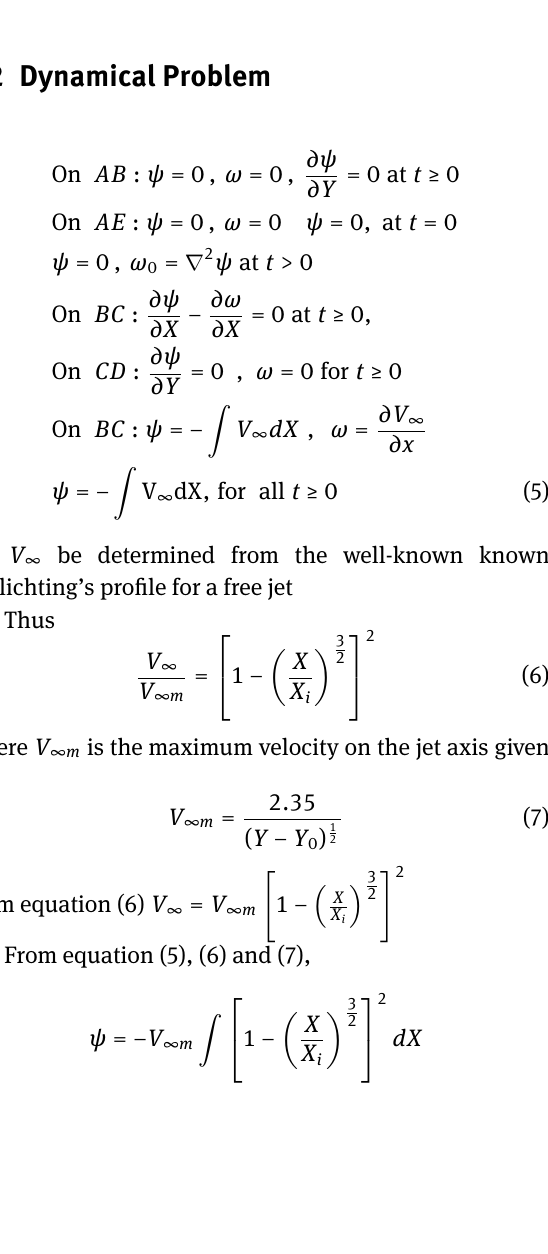
The boundary conditions have been defined for the dy- namical and heat transfer Problems separately for a hot jet impinging on a flat